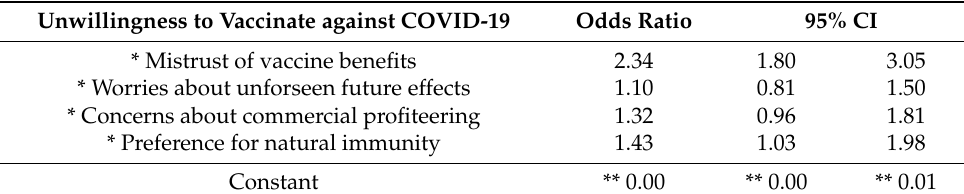
Table 7. Logistic regression model of uncertainty and unwillingness to vaccinate against COVID-19. Unwillingness to Vaccinate against COVID-19 Odds Ratio 95% CI